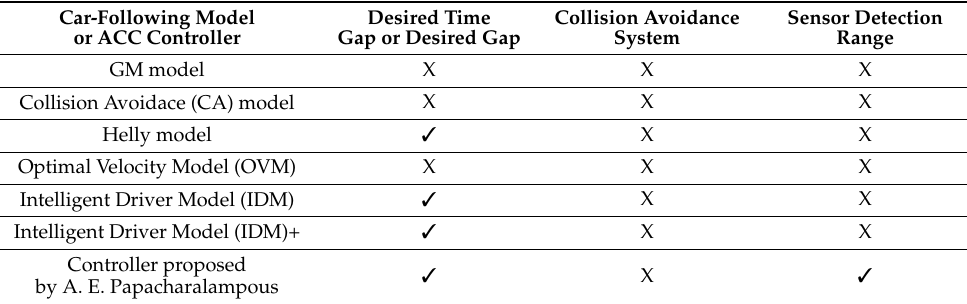
Table 1. The main features of autonomous vehicles that need to be represented in models. Sensor Detection Car-Following Model Desired Time Collision Avoidance Range or ACC Controller Gap or Desired Gap System GM model X X